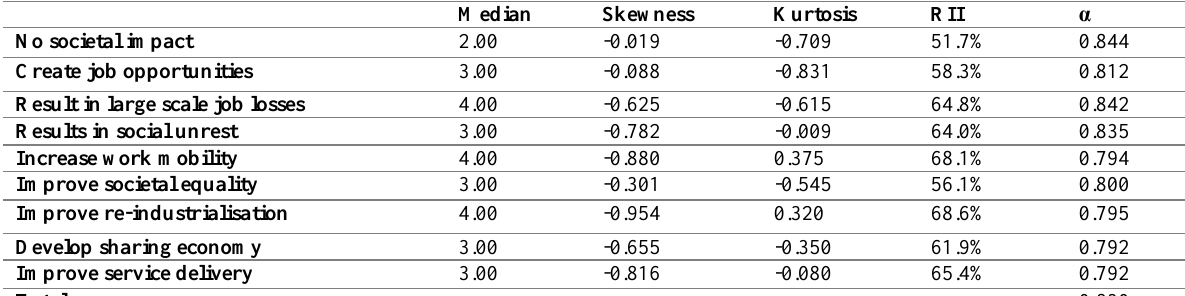
Table 2: Descriptive statistics, relative importance index and reliability of the fourth industrial revolution impact